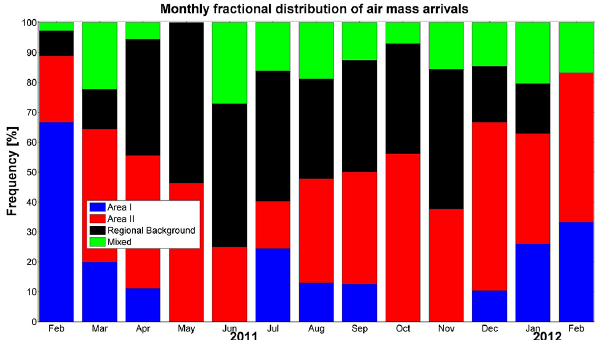
Figure 5. Monthly fractional distribution of VOC samples allocated according to air mass back trajectory sets after passing over the de- fined source